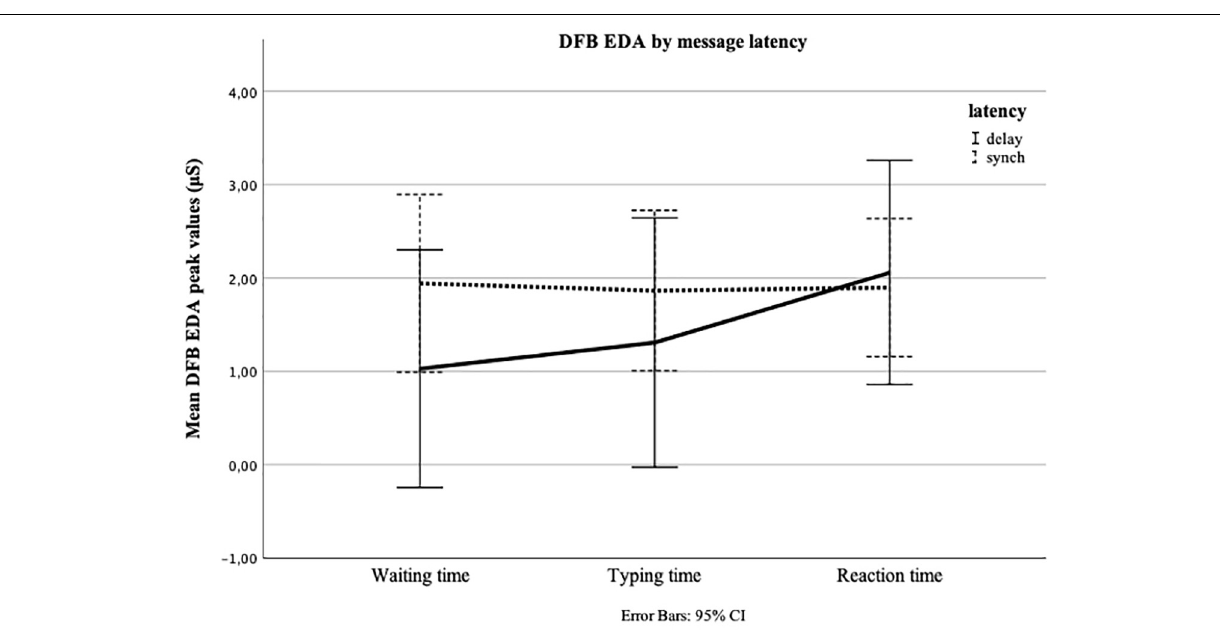
FIGURE 4 | Repeated measures of electrodermal activity (EDA) in microSiemens ( µ S) for Waiting time, Typing time, and Reaction time by message latency (delay = 7 min Waiting time; synch = 1 min Waiting time). The y -axis shows the mean peak value calculated as a deviation from the baseline measure (DFB) for